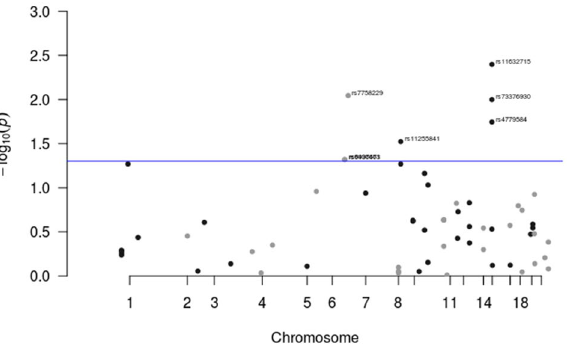
Figure 1. Results for known colorectal cancer susceptibility SNPs. Variants with p-values < 0.05 were flagged for further investigation.